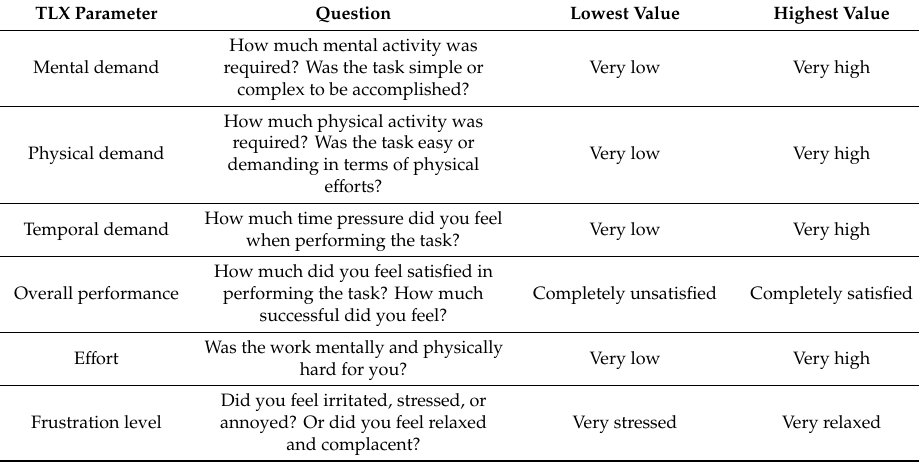
Table 3. NASA TLX questions. The scale ranged from 0 (lowest) to 10 (highest value). TLX